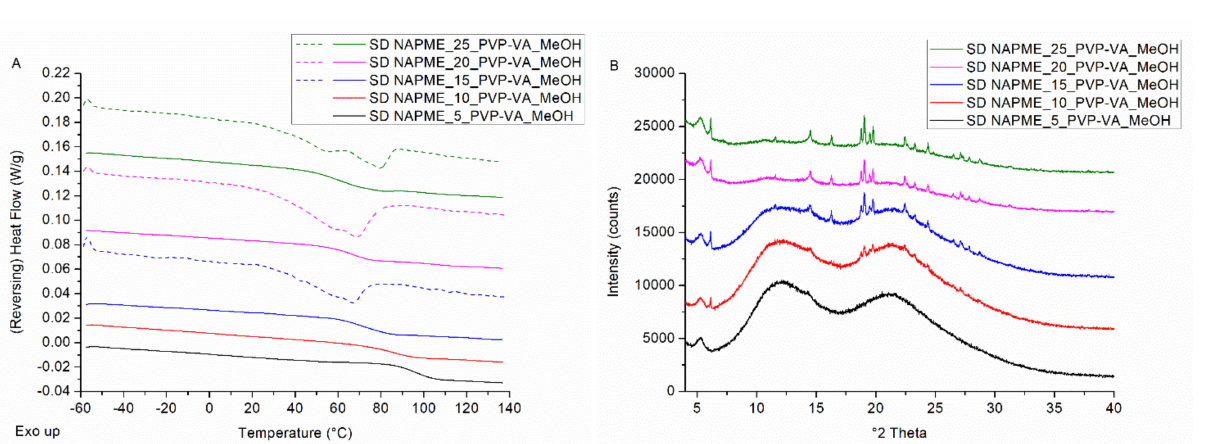
Figure 7. ( A ) mDSC thermograms of spray dried NAPME–PVP-VA systems (SD) with drug loadings from 5% (black) to 25% (green) by intermediate steps of 5%. The THF (dashed) and RHF (solid) signals are shown as arbitrary units. ( B ) Corresponding XRPD diffractograms, where the intensities are also shown as arbitrary units. Table 3. Overview of the phase behavior of NAPME–PVP-VA formulations prepared with bead coating and spray drying. Average T g s, T g widths, T m values and crystallinity percentages ± sd are obtained from mDSC measurements. Residual solvent percentages are derived from TGA analyses. NA = not